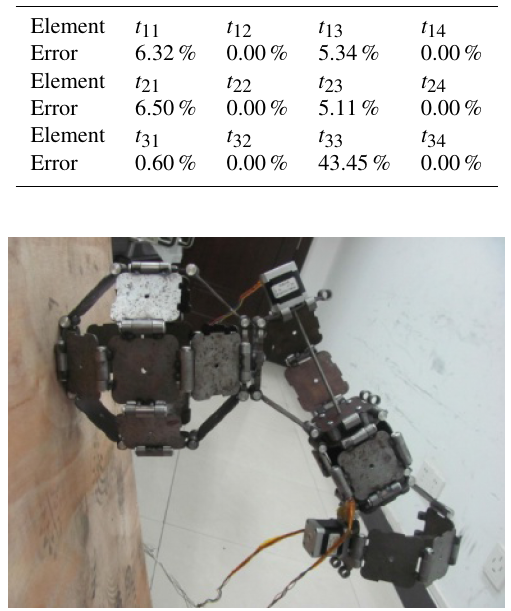
Figure 10. Prototype of the proposed bio-inspired robotic